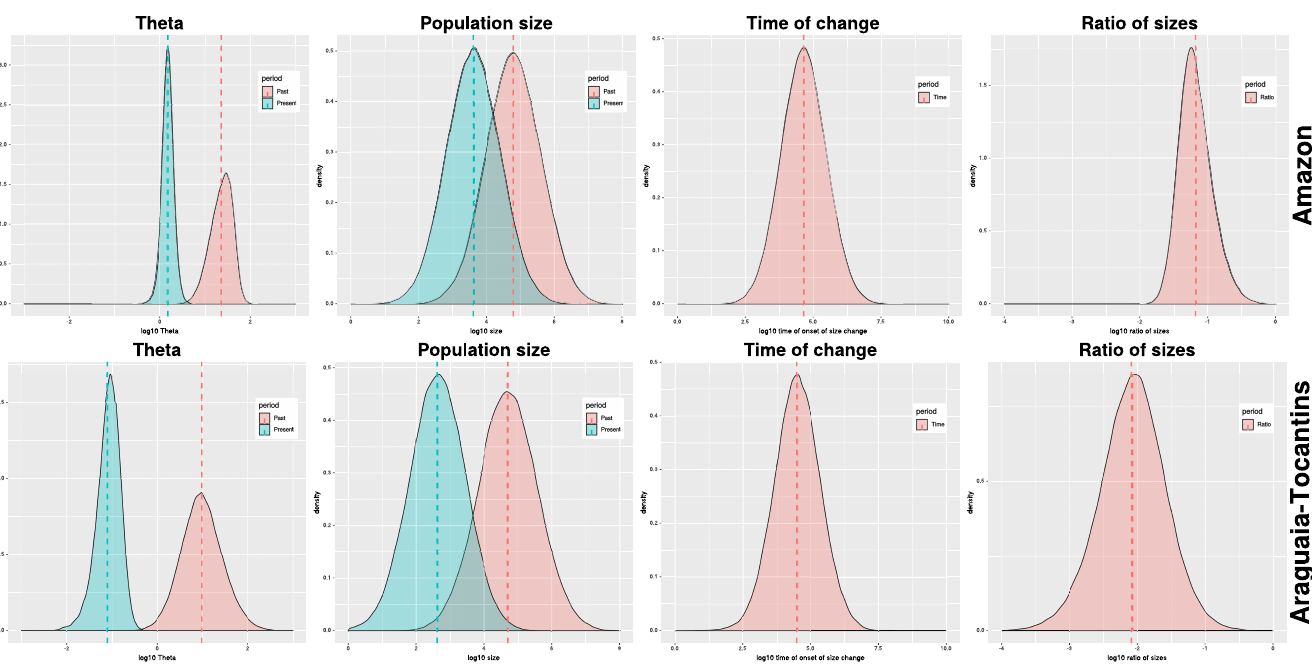
Fig 6. Coalescent population size change, Araguaia-Tocantins vs. Amazon. Note: all metrics are log10 scale. Theta–historical and current theta (4 Neμ ); Population size–historical and current effective population size ( Ne ); Time of change–onset of population size change from historical to current theta; Ratio of sizes–ratio of current to historical